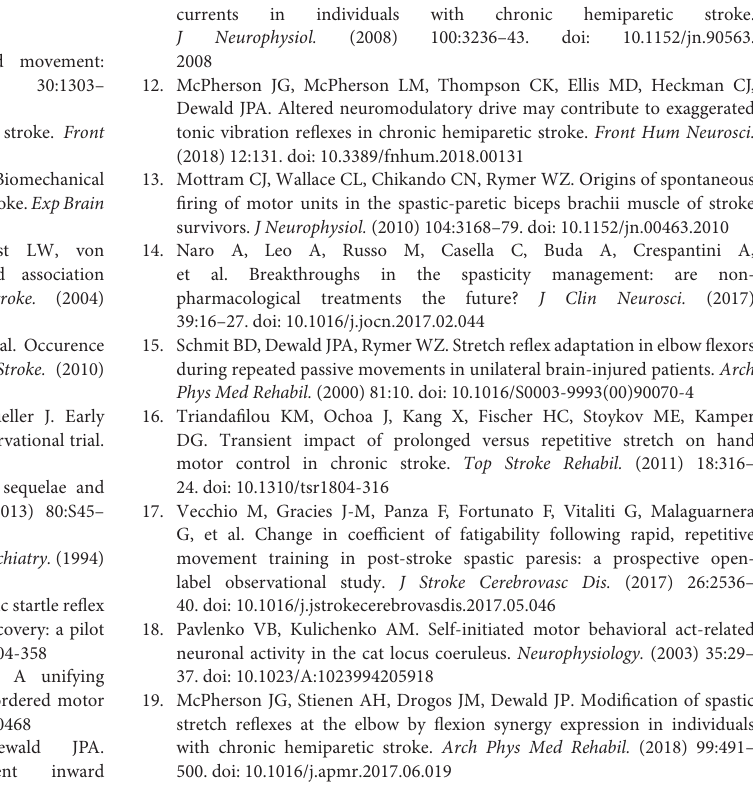
Supplementary Figure 1 | Participants’ short-latency response (SLR) as a function of stretch repetition prior to and following voluntary muscle activation and rest. The responses for the flexors and extensors are identified by the muscle activity of the biceps brachii and triceps brachii, respectively. Mean (bar height) and lower and upper 95th percentile confidence intervals (error bars) are identified. A line with a star above indicates a significant difference between sets. An individual star indicates stretch repetitions that significantly differ from subsequent stretch repetition(s). Post-hoc comparisons for each significant stretch repetition are provided in Supplementary Figure 3 . Supplementary Figure 2 | Participants’ long-latency response (LLR) as a function of stretch repetition prior to and following voluntary muscle activation and rest. The responses for the flexors and extensors are identified by the muscle activity of the biceps brachii and triceps brachii, respectively. Mean (bar height) and lower and upper 95th percentile confidence intervals (error bars) are identified. A line with a star above indicates a significant difference between sets. An individual star indicates stretch repetitions that significantly differ from subsequent stretch repetition(s). Post-hoc comparisons for each significant stretch repetition are provided in Supplementary Figure 3 . Supplementary Figure 3 | Post-hoc comparisons for the results presented in Supplementary Figures 1 , 2 during the voluntary muscle activation and rest sessions. Rows identify the ith stretch repetition, and columns identify subsequent stretch repetitions. Rows are not included for stretch repetitions that didi not have significance. Significance is represented using shading—white: p > 0.050; light gray: p < 0.050; darker gray: p < 0.010; darkest gray: p <